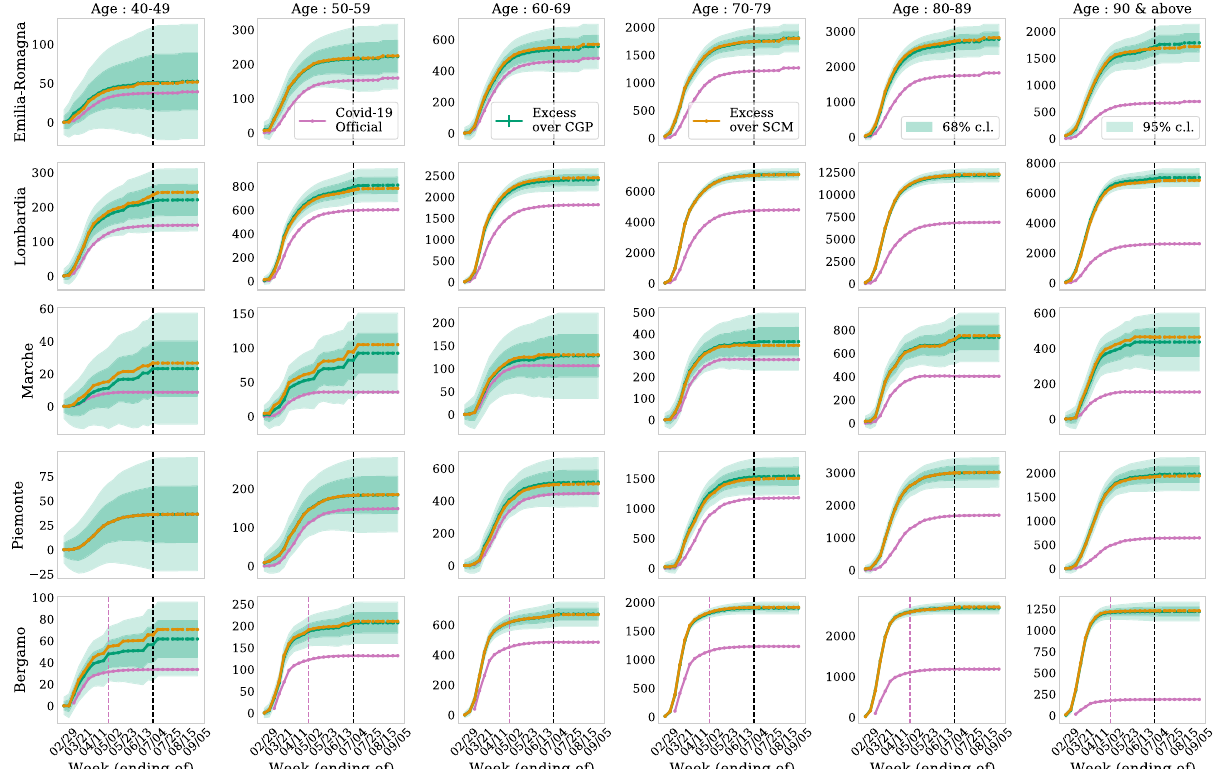
Fig. 3 Age distribution of excess mortalities. Same as Fig. 2b but for different age groups. We fi nd a statistically signi fi cant excess over the reported COVID-19 deaths that is increasing with